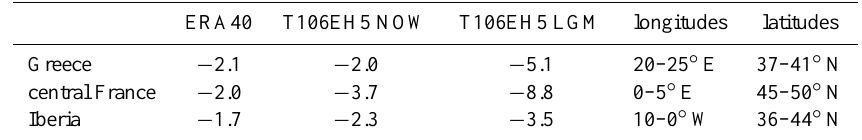
Table 2. Extreme cold 2m temperature anomalies during winter (DJF) in recent years in the ERA40 analyses and in the T106EH5 simulations for the present and for the LGM for land points only on a T106 grid.